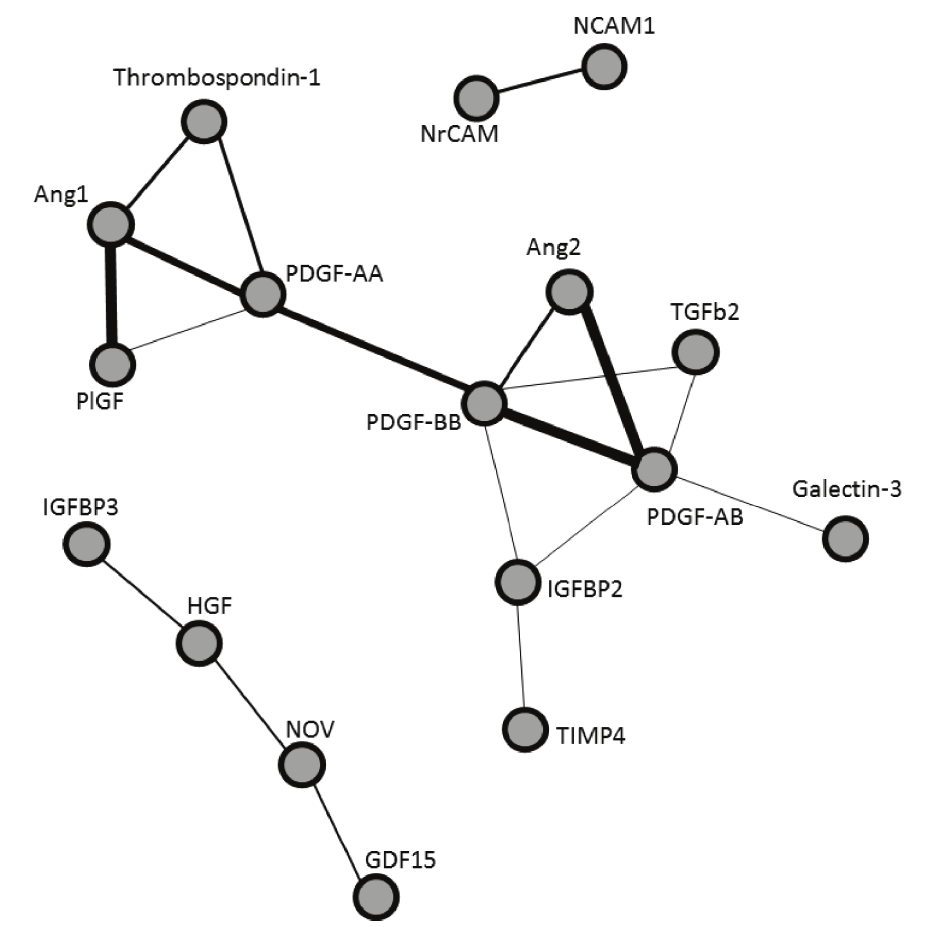
Fig 3. Coregulation of proteins. Pearson correlations betweenQuantibodyprotein profilesover all samples as calculatedfor all pairs of proteins. The proteins are presentedin a correlation network in which the nodes representproteins and the interconnecting lines represent the correlationbetweenthe proteins. The thickness of the lines represent the strength of the correlation. All correlations < 0.7 and disconnectedproteinswere